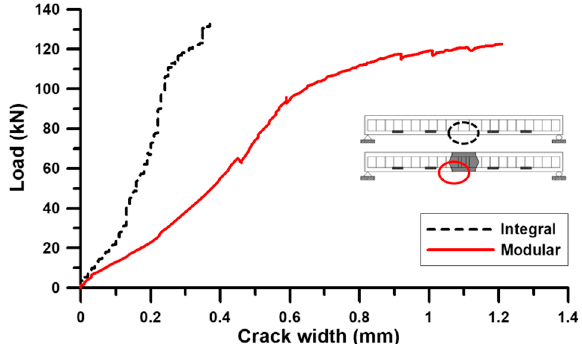
Figure 5. Crack width for the integral and modular specimens.